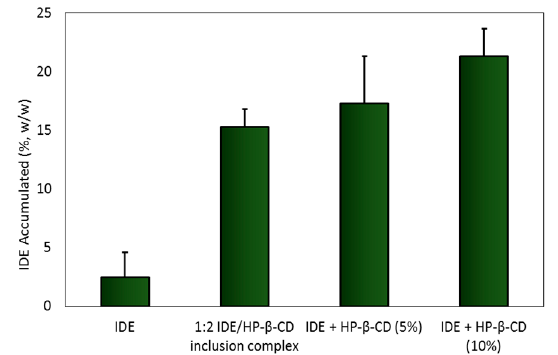
Figure 21. Amounts of IDE accumulated into the excised bovine nasal mucosa at the end of the permeation experiment (4 h). Results are presented as the means of six different experiments ± standard deviation.